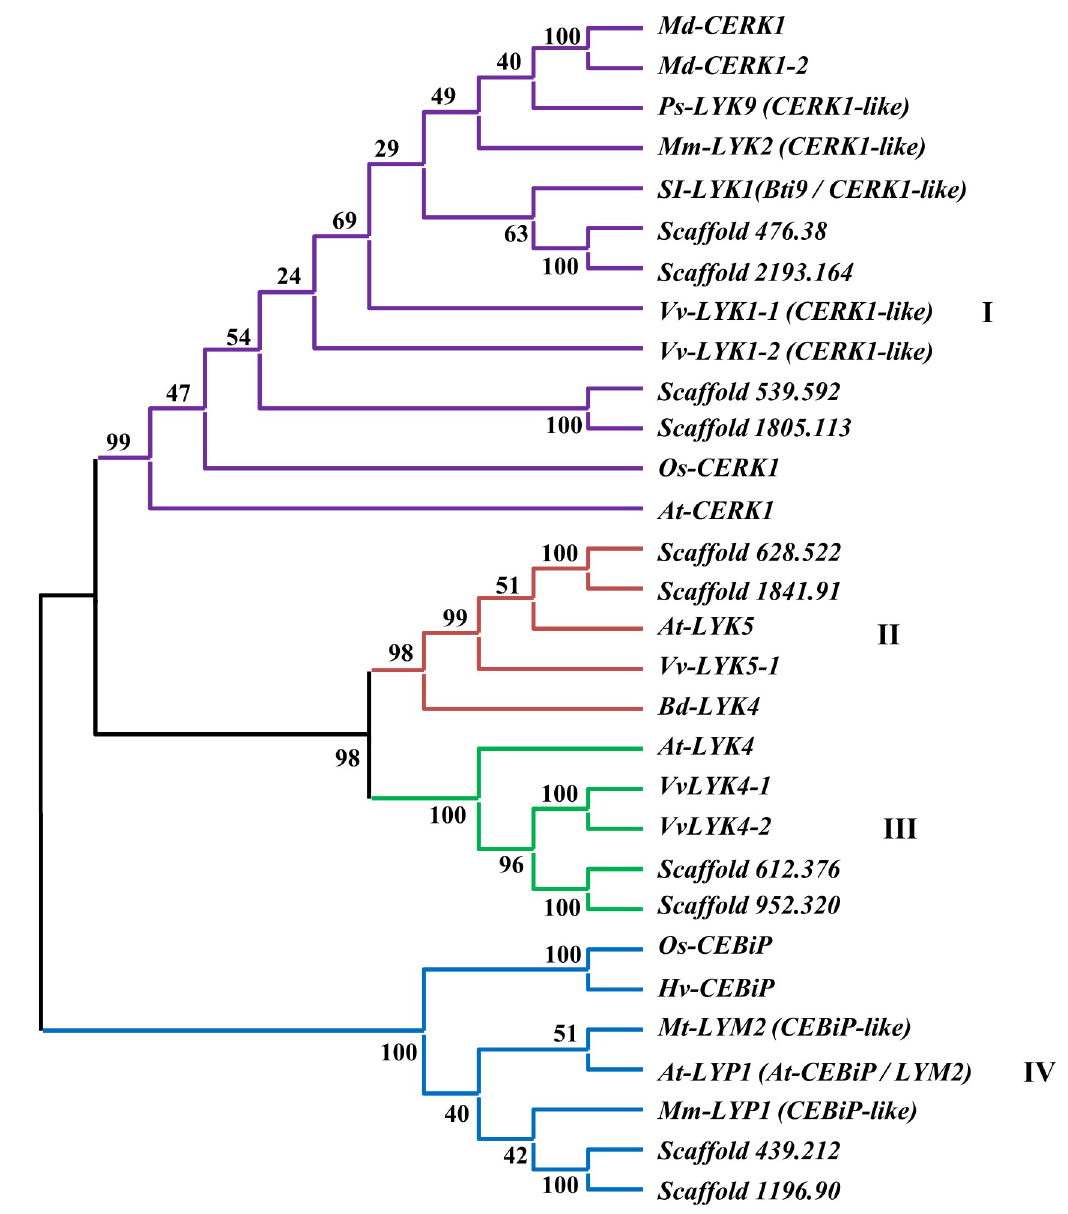
Fig 4. Joint phylogenetic analysis of candidate sequences in C . arabica , reference sequences and homologs described experimentally. The phylogenetic tree was constructed with alignments of complete amino acid sequences using the Maximum Likelihood method with a bootstrap of 1000 repetition. The CERK1 , LYK5 , LYK 4 and CEBiP -Like clades are highlighted in different colors: I- purple, II- red, III- green and IV-